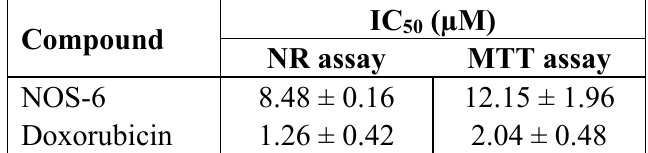
values for NOS-6 and 50